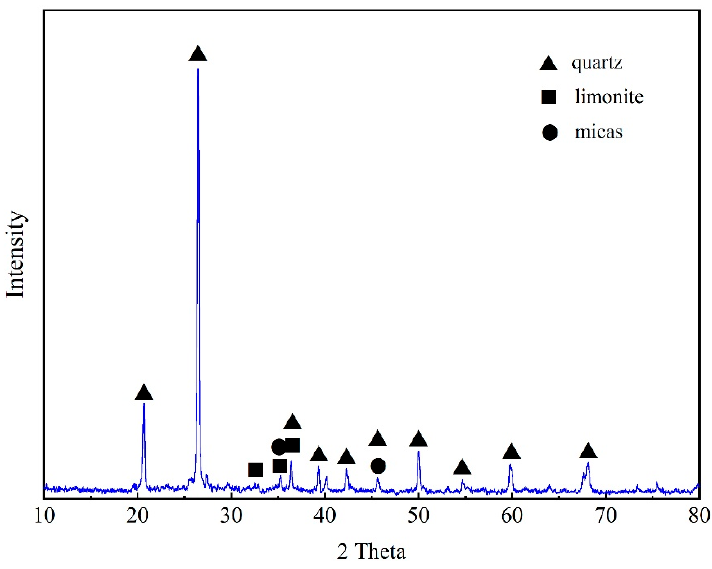
Figure 1. XRD characterization of stone coal.